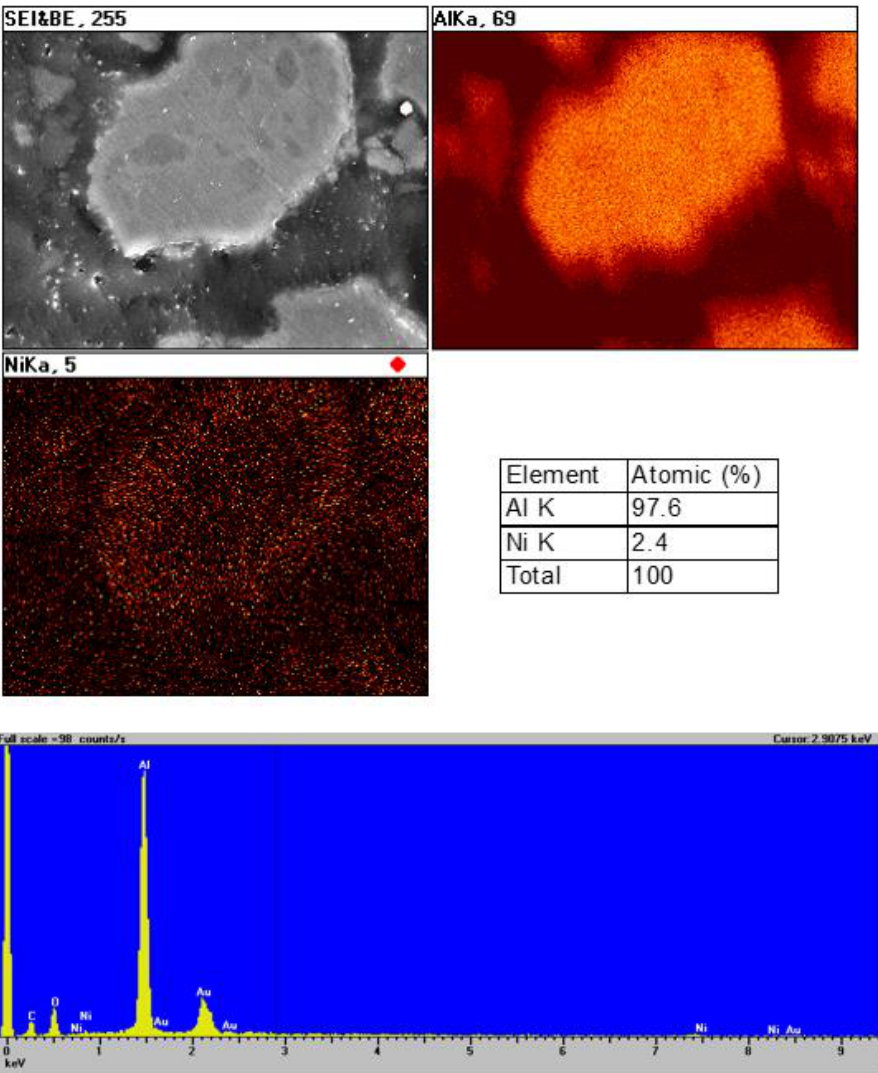
Figure 18. SEM image and EDS elemental mapping of representative Ni-impregnated Al 2 O 3 sample: Al 2 O 3 -CH-Ni-oc-4 (10,000 ppm Ni).